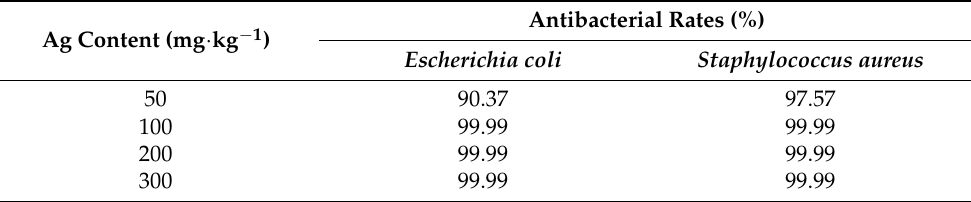
Table 1. Antibacterial rates of TPU nanofiber membrane with Ag contents ranging from 0 mg · kg − 1 to 300 mg · kg − 1 after 50 times of standard